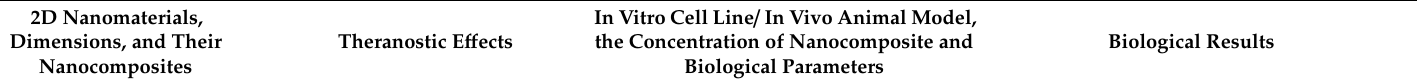
In Vitro Cell Line / In Vivo Animal Model, Theranostic E ff ects the Concentration of Nanocomposite and Biological Parameters A549 tumor-bearing BALB / c nude mice; 5 groups, 1 mg / mL of